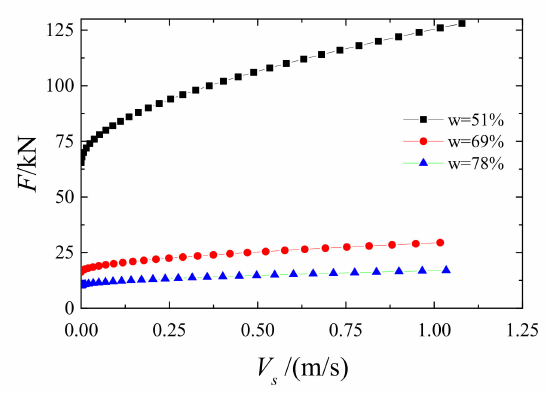
Figure 4. Applied thrust-speed curves.